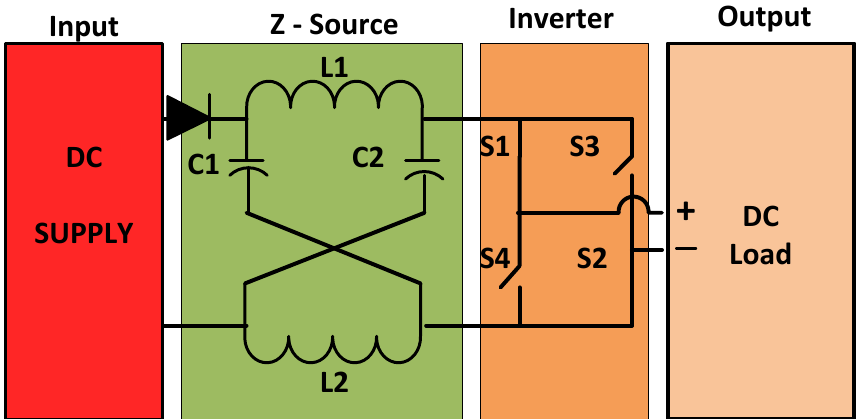
Figure 8. Z-Source DAD converter, – DC – DC converter mode.